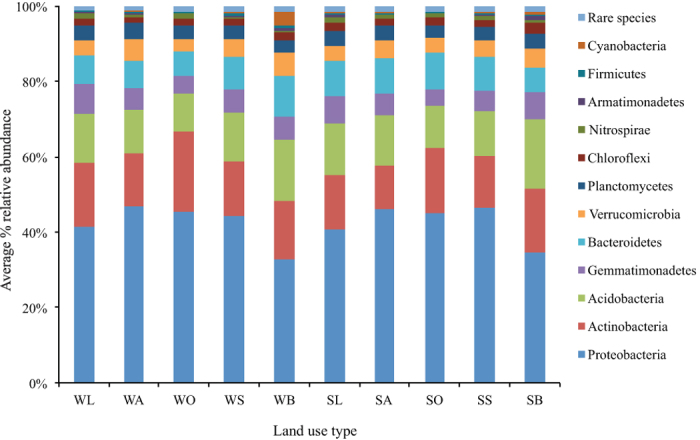
The relative abundances of major taxonomic groups at the phylum level for bacteria across all land-use types in winter and summer.Relative abundances are based on the proportional frequencies of bacterial DNA sequences that could be defined at the phylum. Site abbreviations starting with S and W indicate sampling in summer and winter, respectively. The land use types and their abbreviations are: oak forest (SO and WO), oriental arborvitae forest (SA and WA), black locust plantation (SL and WL), shrub land (SS and WS), and bare land (SB and WB) respectively. The figure is generated by using the R v.3.1.3 project (R Development Core Team. 2015).